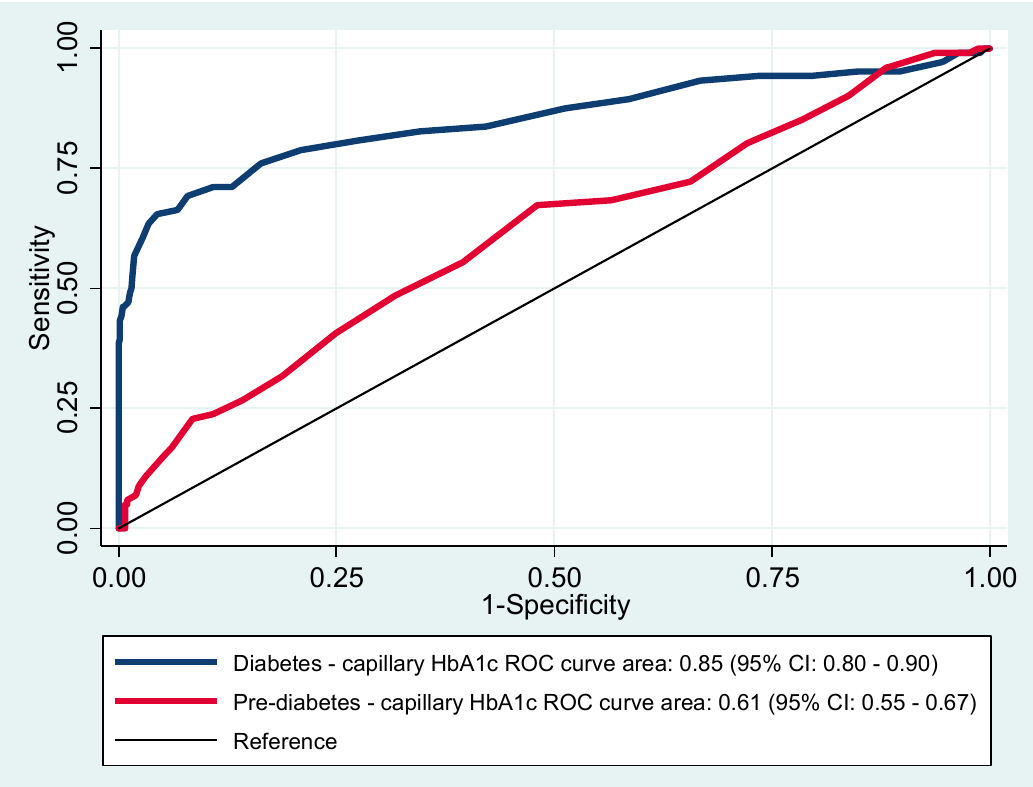
Figure 1. Receiver operating characteristics (ROC) curves for HbA1c (glycated hemoglobin) to diagnose diabetes and pre-diabetes.